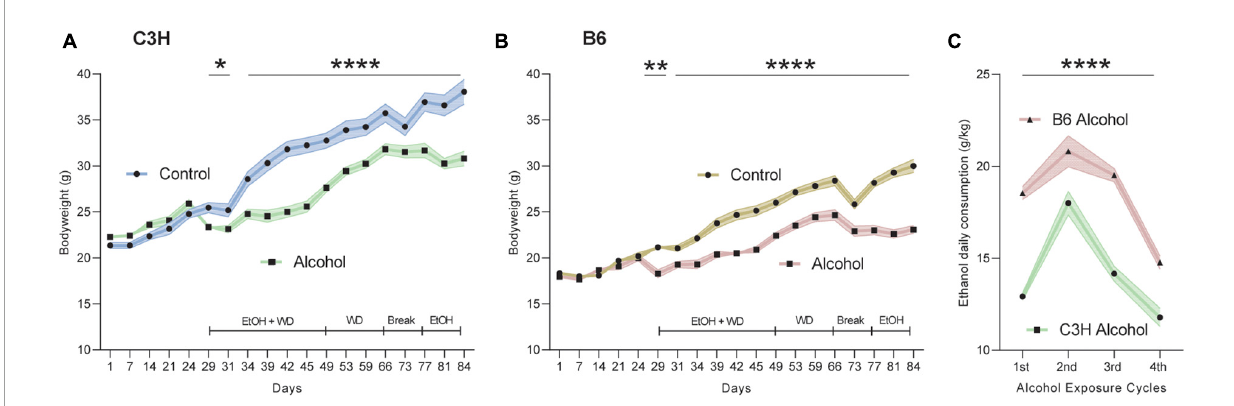
FIGURE2 Bodyweight and alcohol intake over time. Bodyweight in grams during the whole experiment for C3H (A) and B6 (B) mice. Alcohol intake as g/kg/day over the four exposure periods for C3H and B6 mice (C) . Data are shown as group means, with the shaded area representing ± SEMs. n = 12. **** p < 0.0001, ** p < 0.01, and * p < 0.05 represent mixed model repeated measures (MMRM) followed by Benjamini–Hochberg’s post hoc , alcohol vs. control (A,B) and C3H vs. B6 (C)